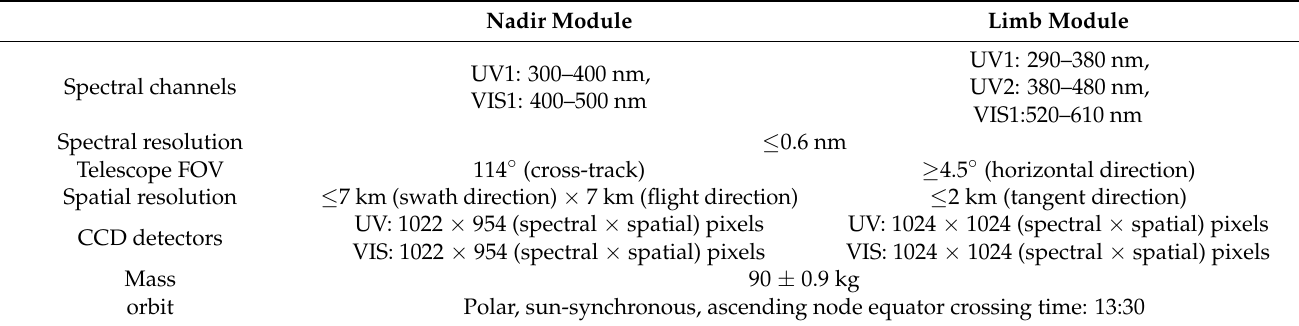
Figure 1. Diagram of EMI-NL in-orbit observation. Table 1. EMI-NL instrumental properties.